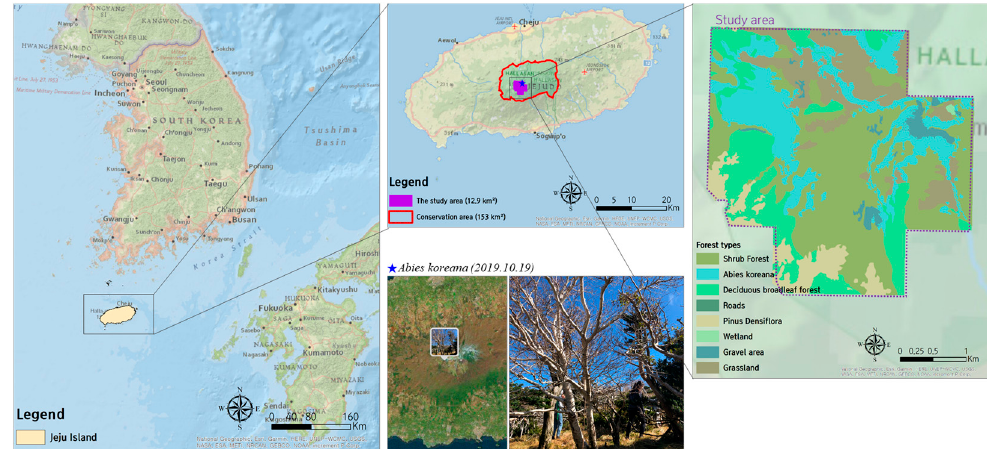
Figure 1. Location of the study site on Jeju Island, Republic of Korea.